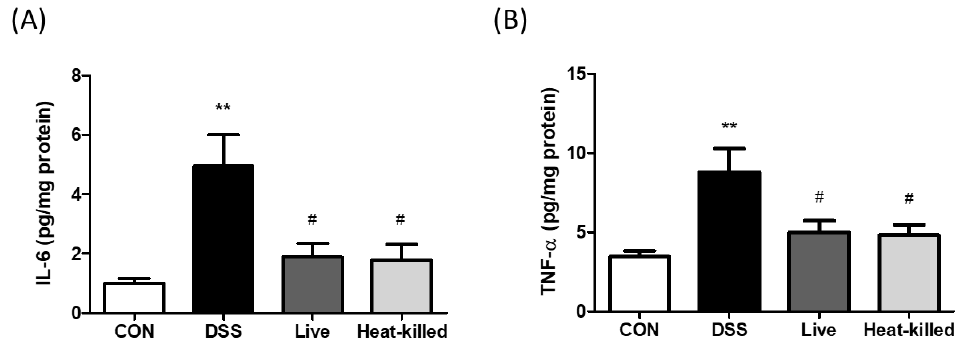
Figure 4. Levels of pro-inflammatory cytokines IL-6 ( A ) and TNF- α ( B ) in the colon tissue of DSS- induced colitis mice. Data are presented as mean ± SD. ** p < 0.01 versus the CON group, and # p < 0.05 versus the DSS group.